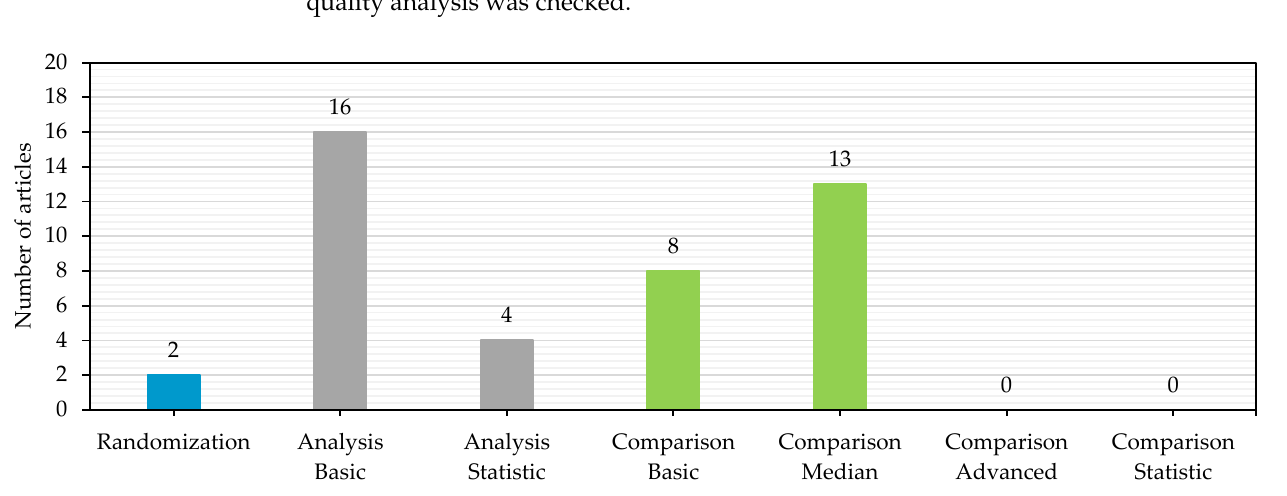
Figure 6. Items checked in the methodology quality analysis.